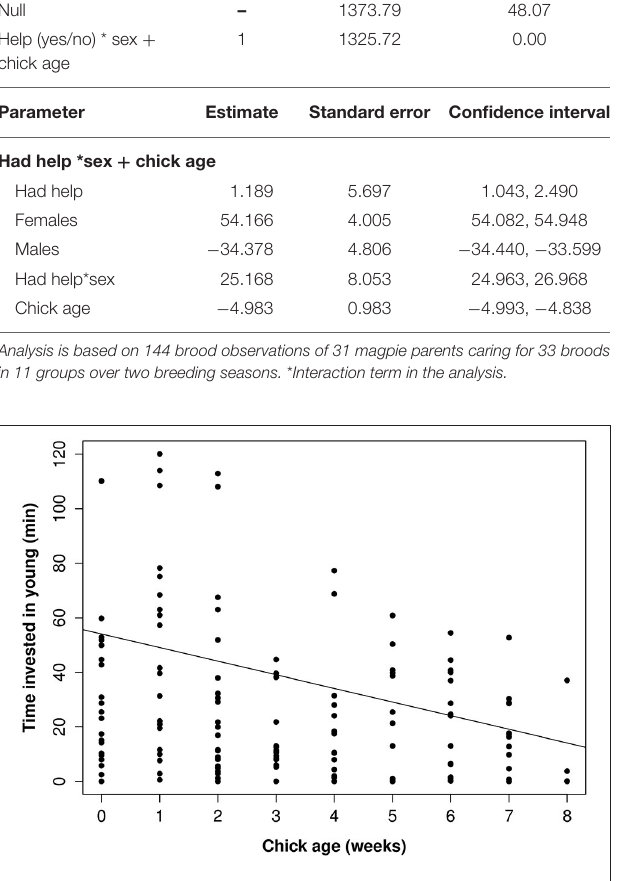
FIGURE 6 | The relationship between how much time parents invested in young according to chick age (nestling phase 0–4 weeks, fledgling phase 4–8 weeks). Raw data values are displayed against the line of best fit generated from the top model presented in Table 4 .